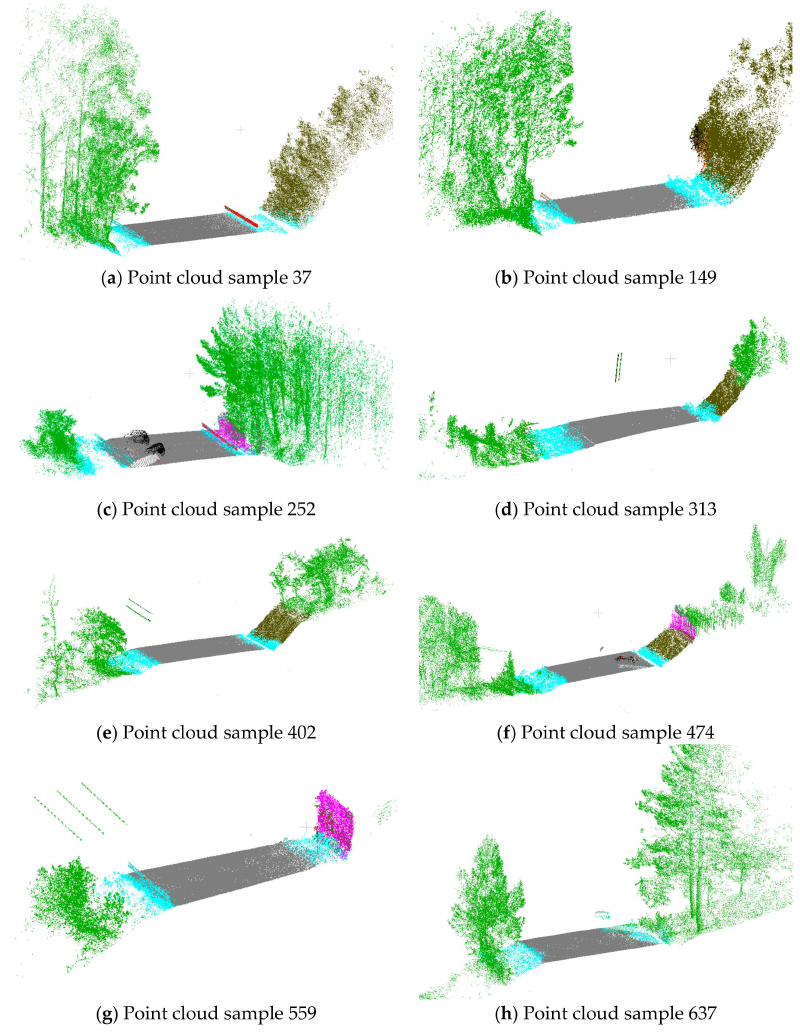
Figure 6. Segmented point cloud samples with PointNet. Color code: road surface in dark grey, ditch in blue, embankments in brown, border in green, guardrail in orange, and fences in